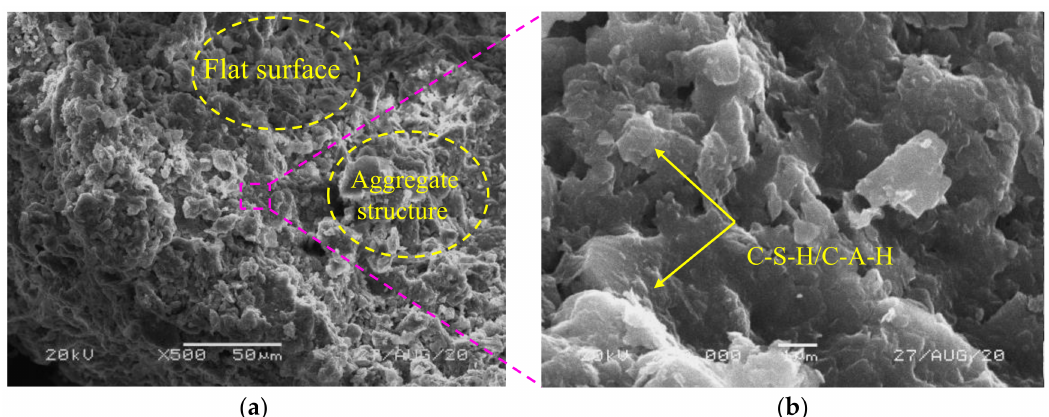
Figure 11. SEM images of LS: ( a ) 2000 × ; ( b ) 5000 × .